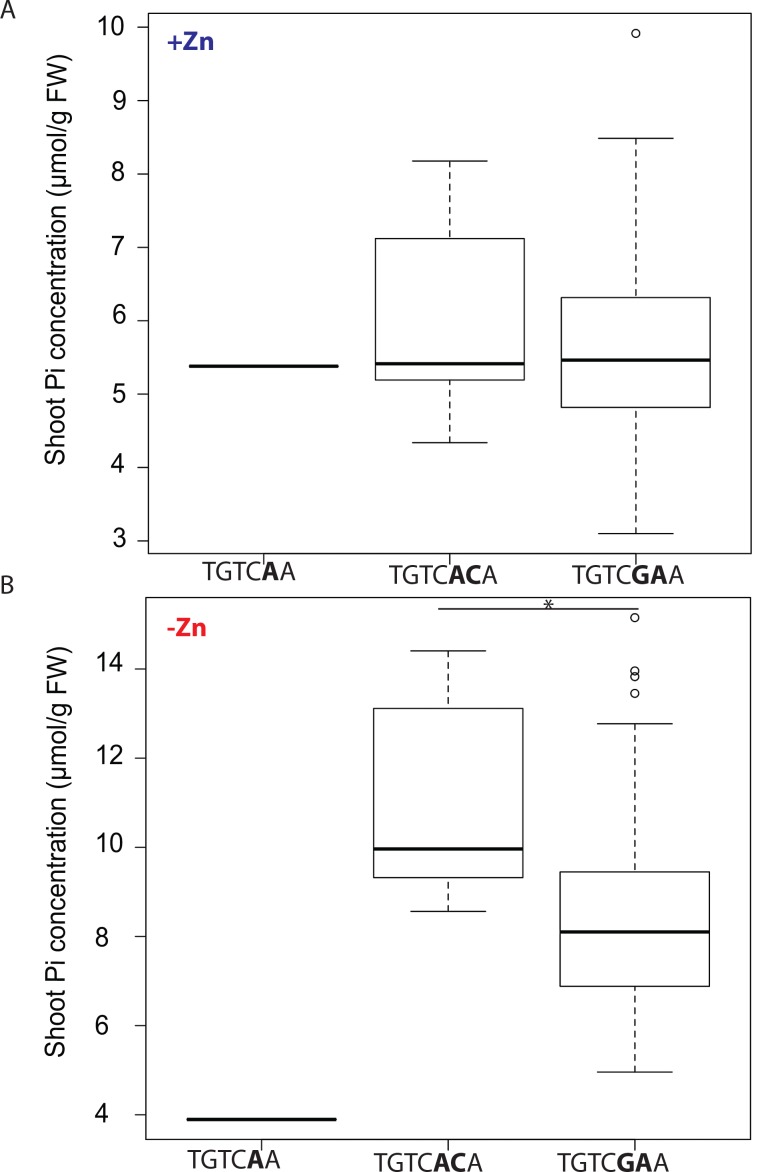
Shoot Pi concentrations in Arabidopsis accessions grouped by new ZDRE motif.Shoot Pi concentrations of Arabidopsis thaliana accessions grown on agar medium supplemented with zinc (+Zn) (A) or without zinc (-Zn) (B) for 18 days under long day conditions. Data same as in Supplementary file 3. Grouping of accessions is based on their ZDRE binding motif allele TGTCAAA, TGTCACA and TGTCGAA respectively. Asterisk indicates a significant difference according to Student’s T-test p<0.01.